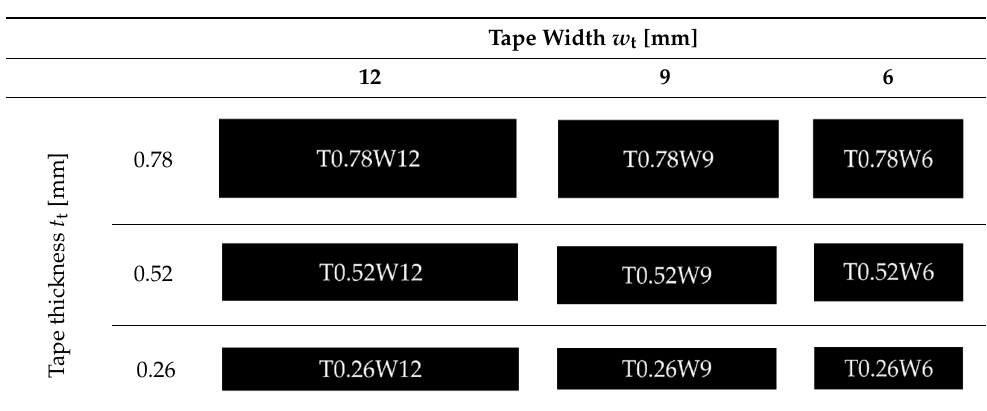
Table 3. Material properties of investigated components [34] (p. 202), [35].